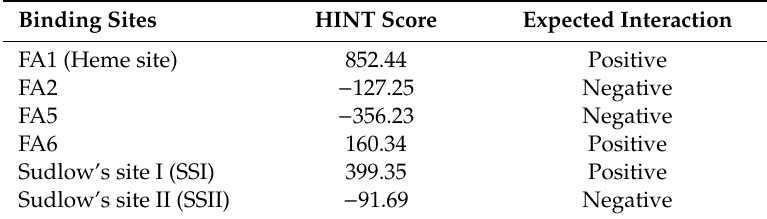
Table 2. Interaction scores between AOH and the di ff erent binding sites in HSA.